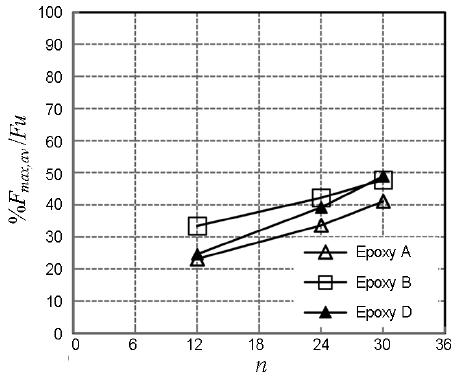
Fig. 12. Effect of epoxy type and bond length for specimens with CFRP bars on %F max,av /F u ; ( n = L b / d b